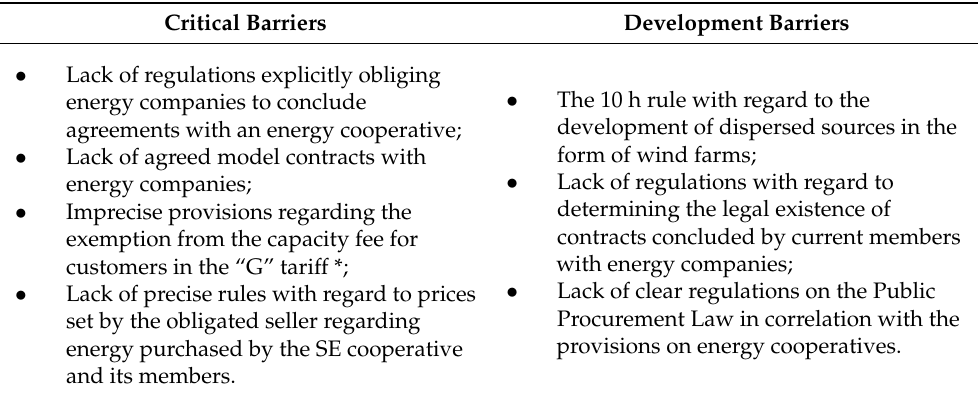
Table 2. Barriers to the development of energy